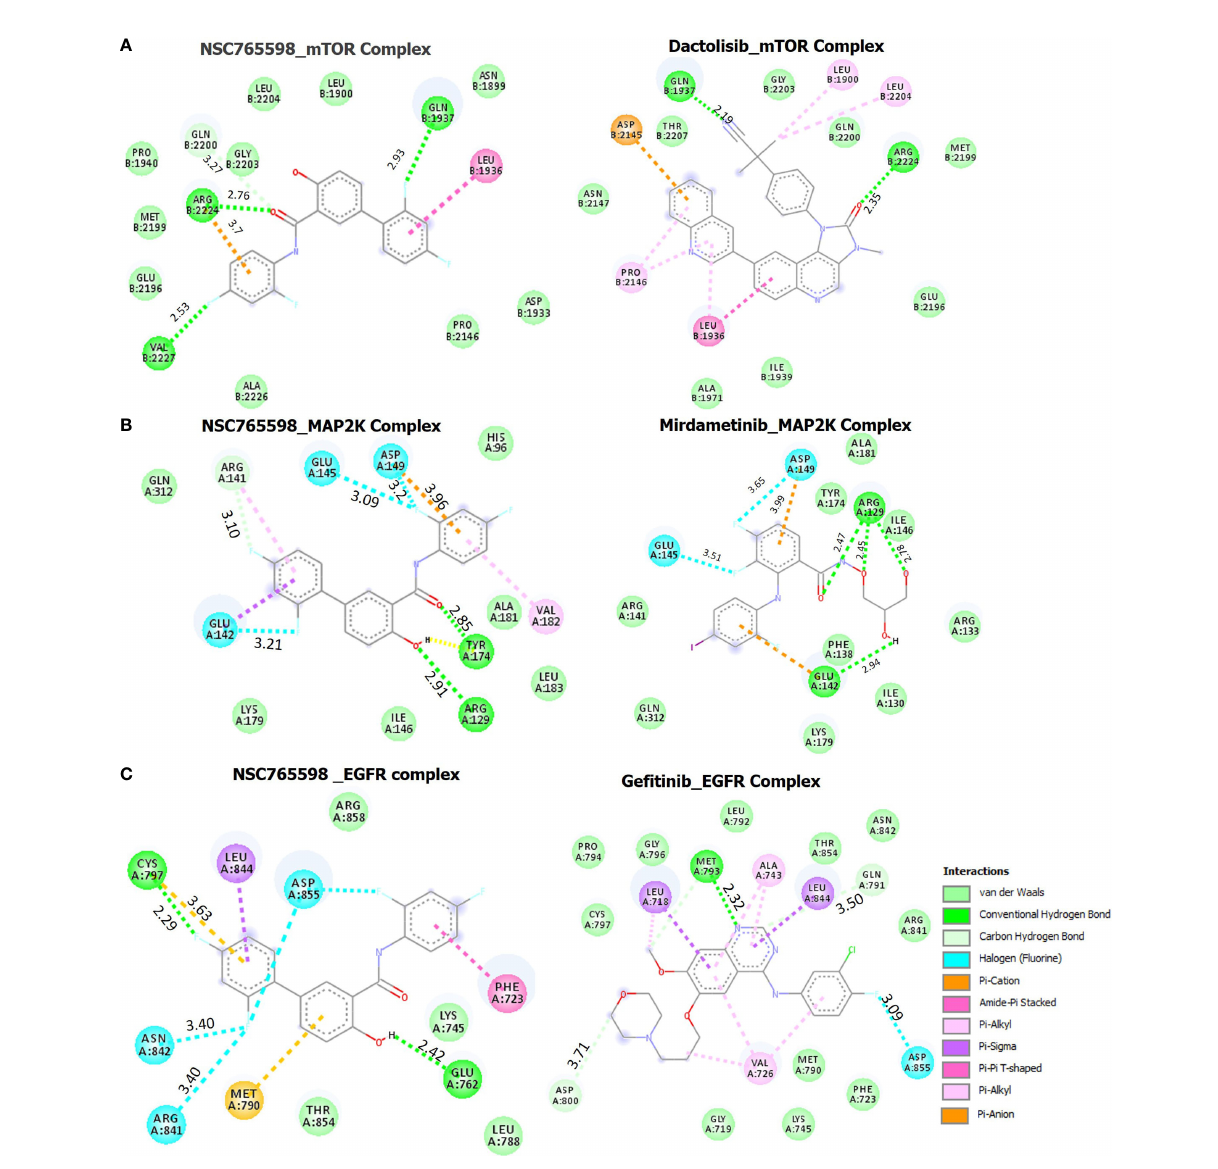
FIGURE 7 | Docking pro fi les of mTOR/MAP2K/EGFR with NSC765598 and standard inhibitors. The two dimensional (2D) representations of ligand – receptor complexes, showing the interacting amino acid residues and the type of interactions, occurring between the ligands and (A) mTOR (B) MAP2K and (C)